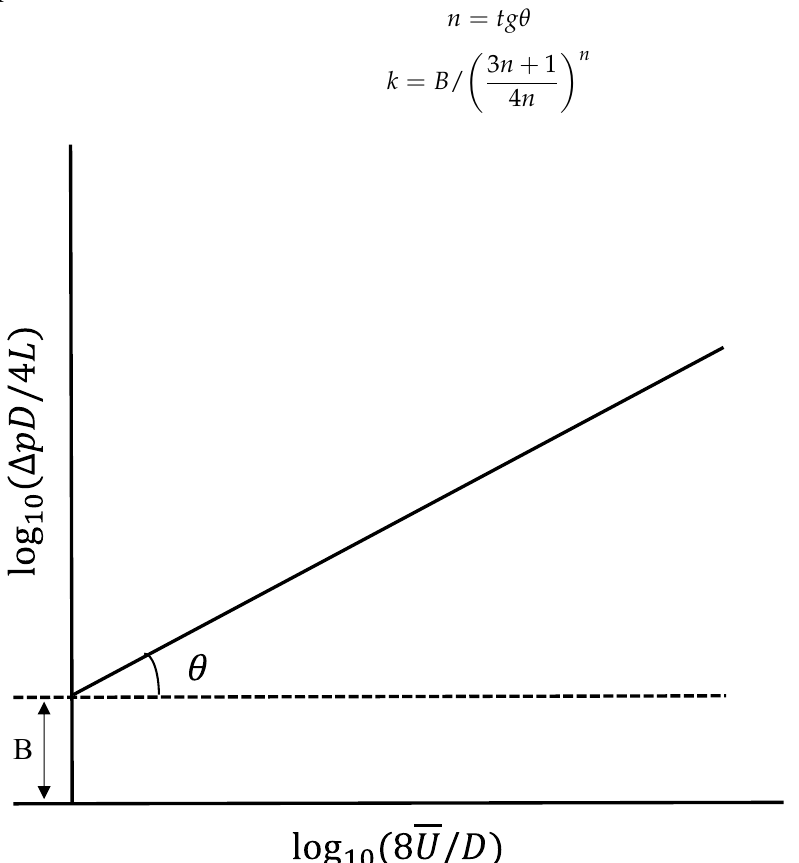
Figure 22. Power-law fluid flow curve (logarithmic coordinates). (Reprinted/adapted with permis- sion from Ref. [9], 2014, copyright X. Sun et